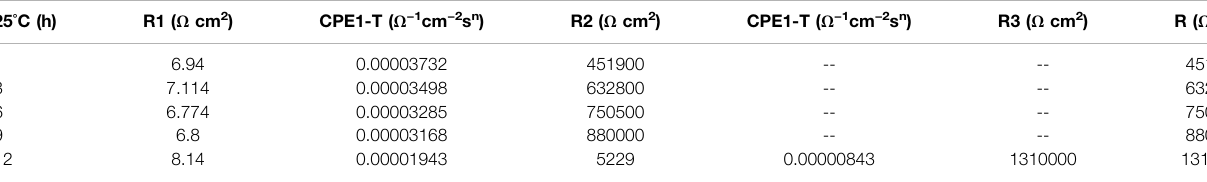
TABLE 9 | Impedance fi tting data of weld zone soaked in arti fi cial seawater at 25 ° C for 12 h 25 ° C